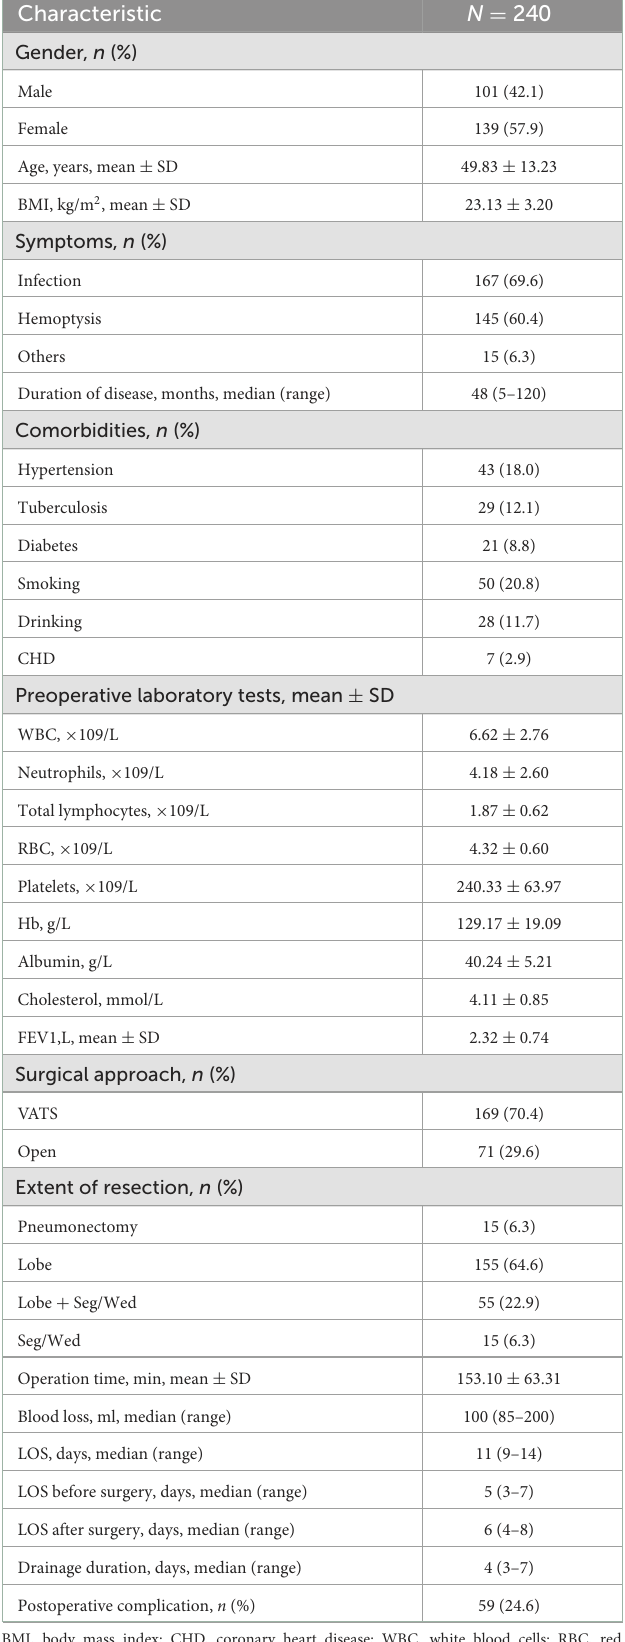
TABLE 1 Baseline characteristics.